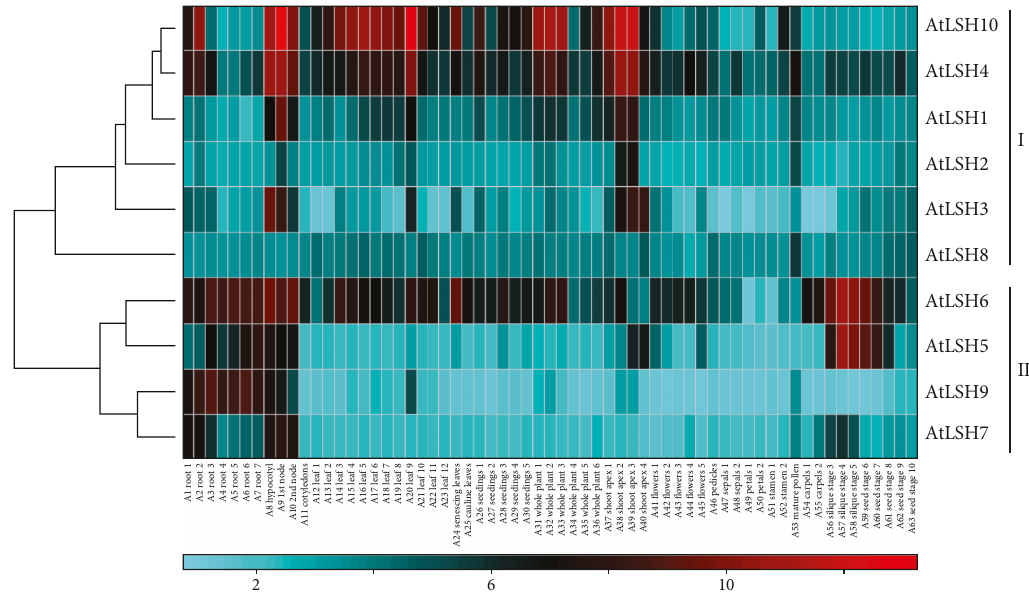
Figure 6: Genome-wide expression pro fi le of ALOG domain genes in Arabidopsis . The hierarchical clustering displays the expression pro fi les of the 10 ALOG domain genes ( AtLSH1 to AtLSH10 ). The color scale at the top left represents the log indicates a low expression level, black indicates a medium expression level, and red indicates a high expression